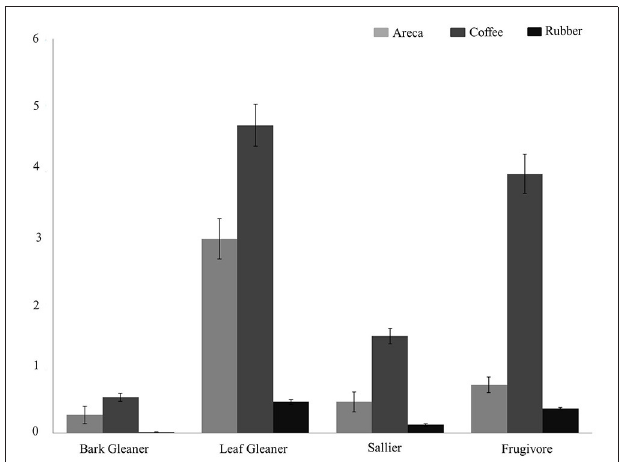
FIGURE 3 | Bird density (per hectare) across the three agroforests for four bird habitat guilds: Low Canopy, Mid Canopy, Mid-high Canopy, High